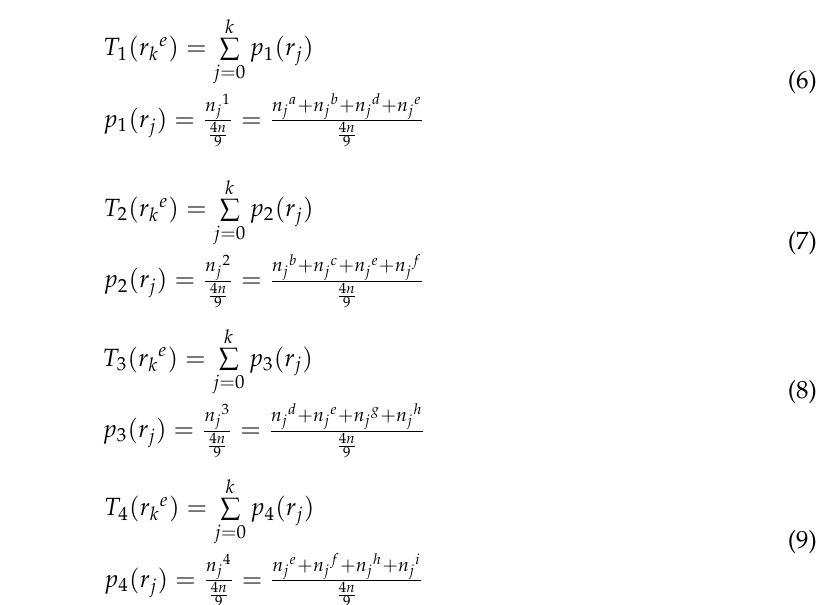
represents the number of pixels in